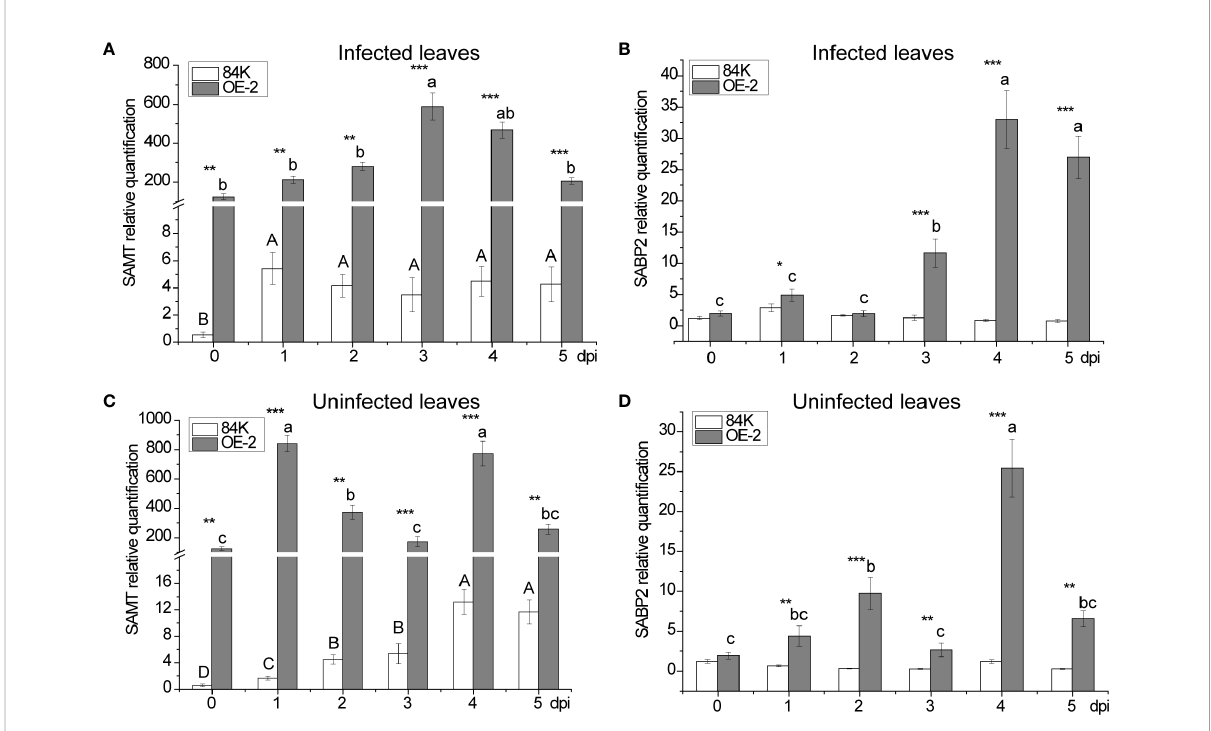
FIGURE 5 Changes in SAMT and SABP2 expression after inoculation with B dothidea . (A) Relative transcript abundance of SAMT in infected leaves. (B) Relative transcript abundance of SABP2 in infected leaves. (C) Relative transcript abundance of SAMT in uninfected leaves. (D) Relative transcript abundance of SABP2 in uninfected leaves. Mean values from three independent plants are given. dpi, days past inoculation. Each bar represents the mean relative expression level of three independent experiments with the standard errors. The bars with asterisks indicate signi fi cant differences between the 84K and OE-2 lines at the same time (* p<0.05 ; ** p<0.01 ; *** p<0.001 ). The uppercase letters are the statistical differences of measured data during the time series of the 84K line, p<0.05 . The lowercase letters are the statistical differences of measured data during the time series of the OE-2 line, p<0.05